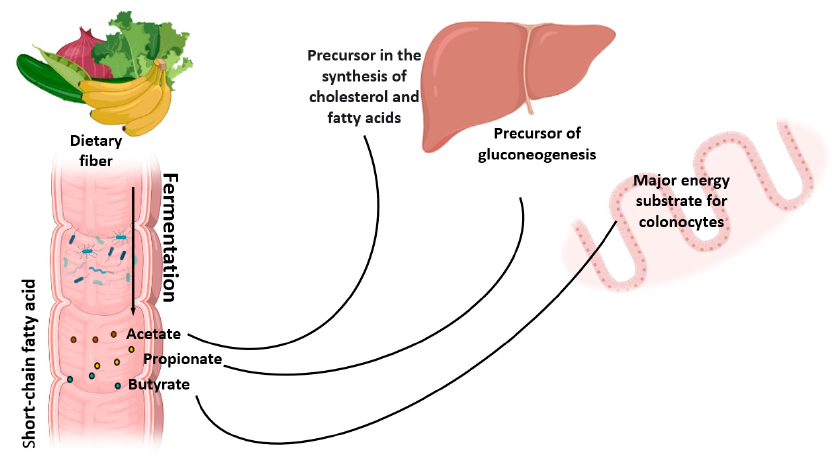
Figure 2. Fiber fermentation and its utilization pathways. Created with BioRender.com.